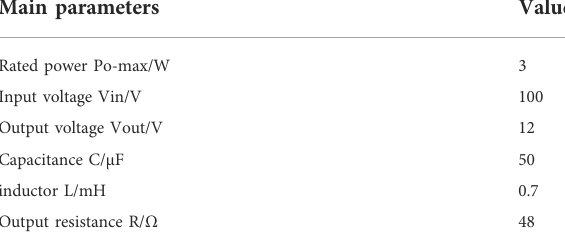
TABLE 1 Main parameters of the Buck converter with rated power of 3W